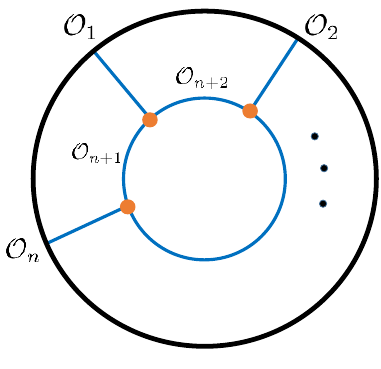
Figure 9. The AdS n